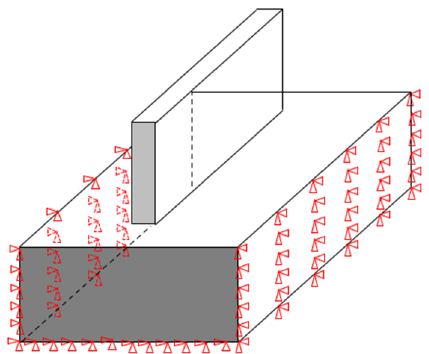
Figure 15. Schematic diagram of setting fixed constraints to the substrate for milling thin-walled